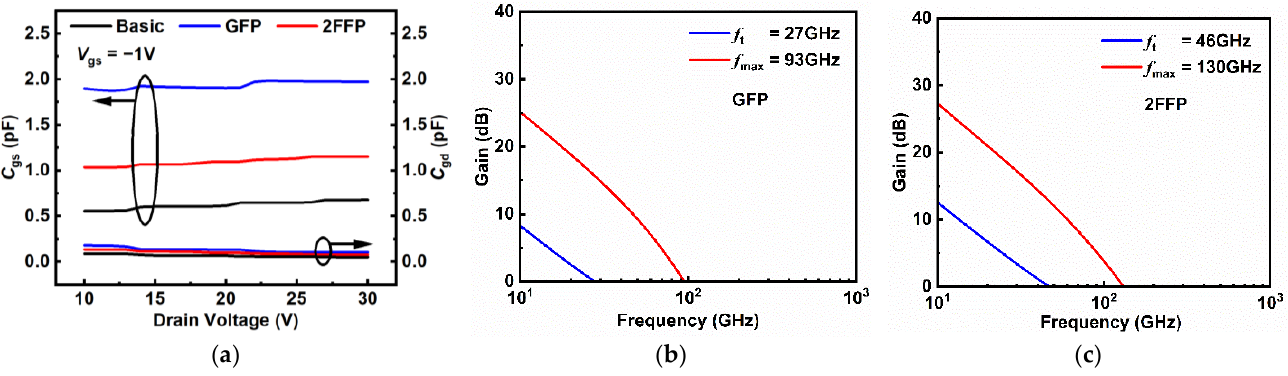
Figure 5. ( a ) Timings and parameter settings in the current collapse measurements, ( b ) relationship between the ON-resistance increase ratio caused by the current collapse phenomenon and the applied voltage as a function of the basic, GFP, and 2FFP structures, and ( c ) conduction/valence band energy of the GFP and 2FFP devices during the ON-state and OFF-state extracted from the upper bound of AlGaN to the lower bound of GaN at the drain-side edge of the gate.